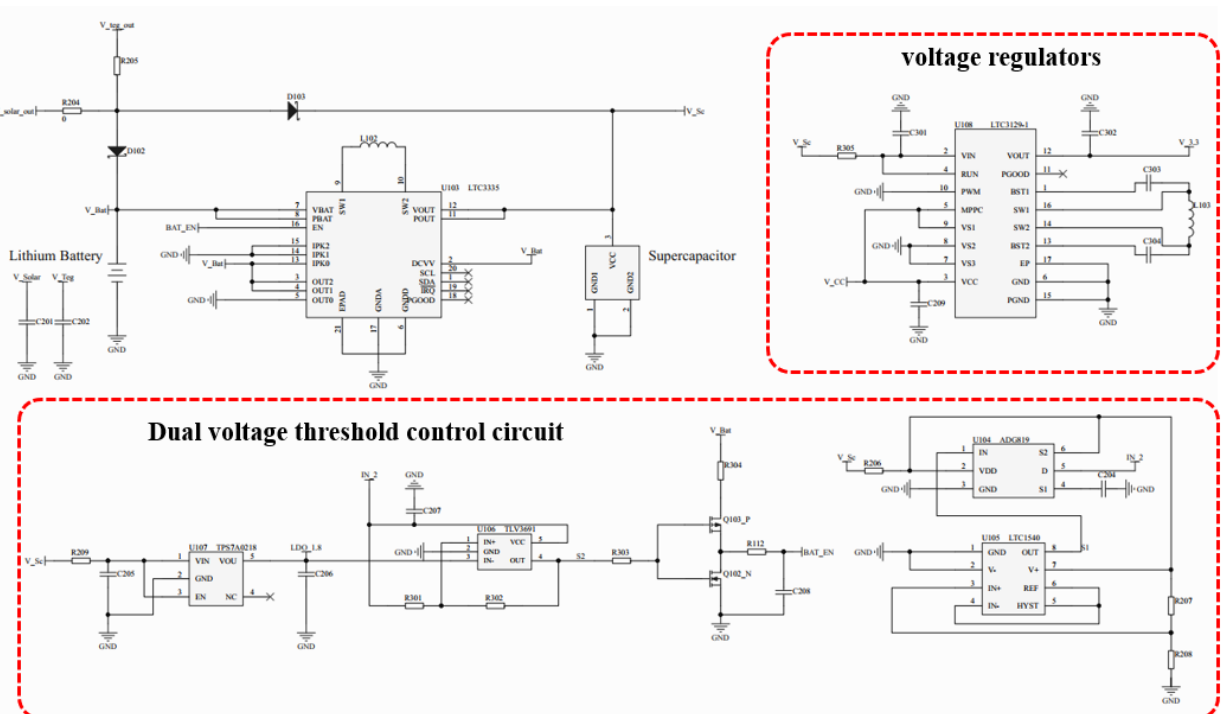
Figure 5. Schematic diagram of energy management circuit.